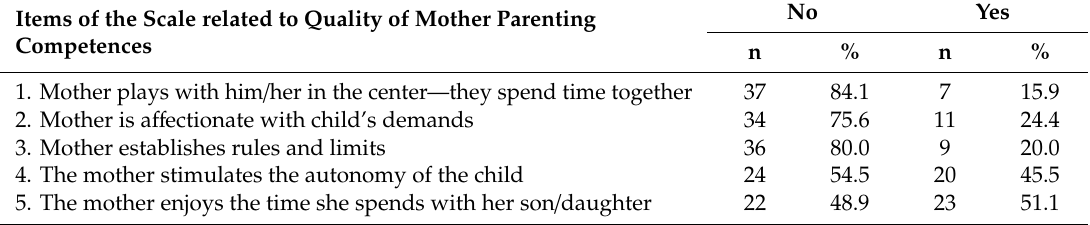
Table 2. Frequency and percentages for the items of the scale related to parenting